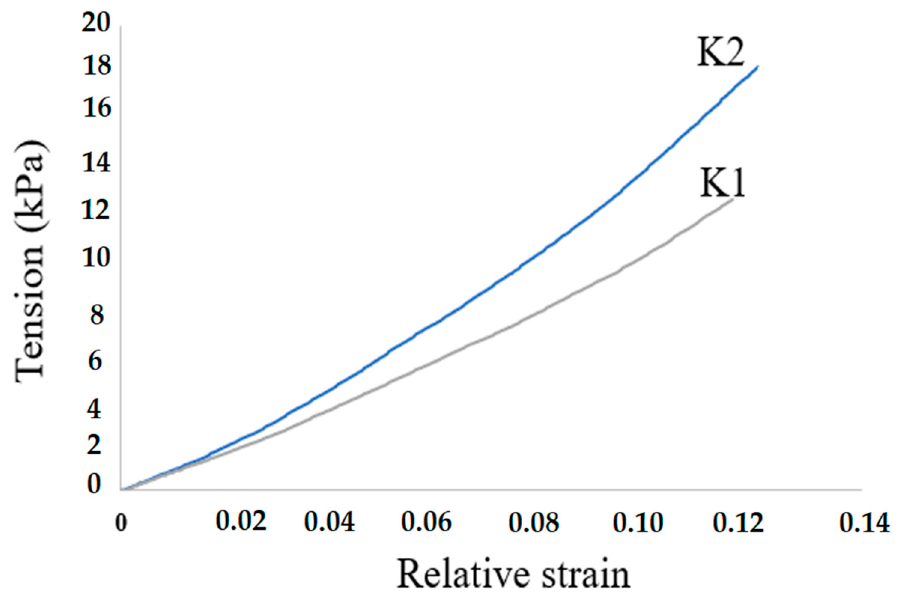
Figure 4. Dependences of the relative deformation of samples of composites K1( a ) and K2( b ) on stress.